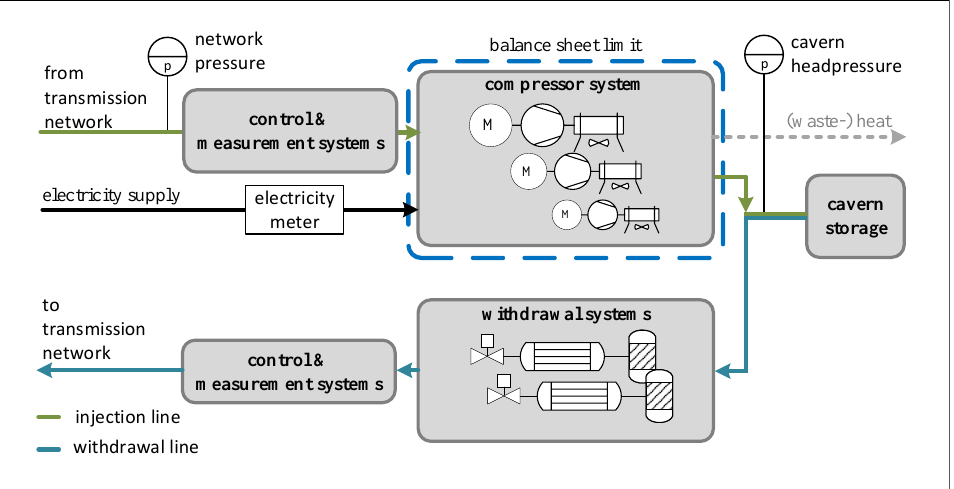
Figure 1. Simplified gas and energy flow diagram of a gas storage facility. Source: Own representation on the basis of information provided by